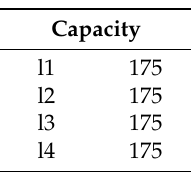
Table A17. Capacity of transmission line between nodes s and m (MW): l_max( l ).